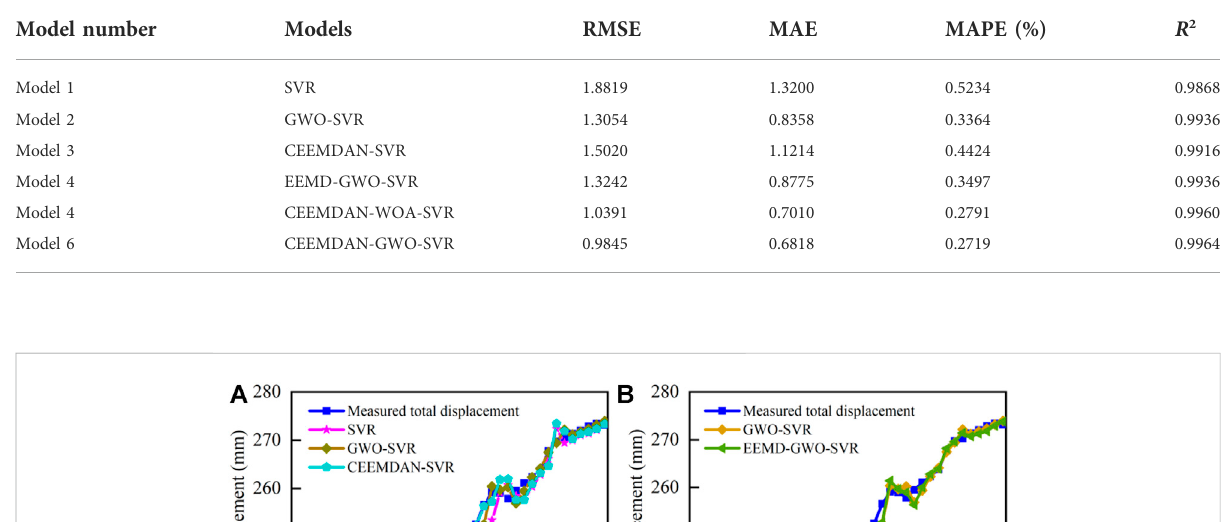
TABLE 3 Comparison of prediction accuracy of different prediction models.